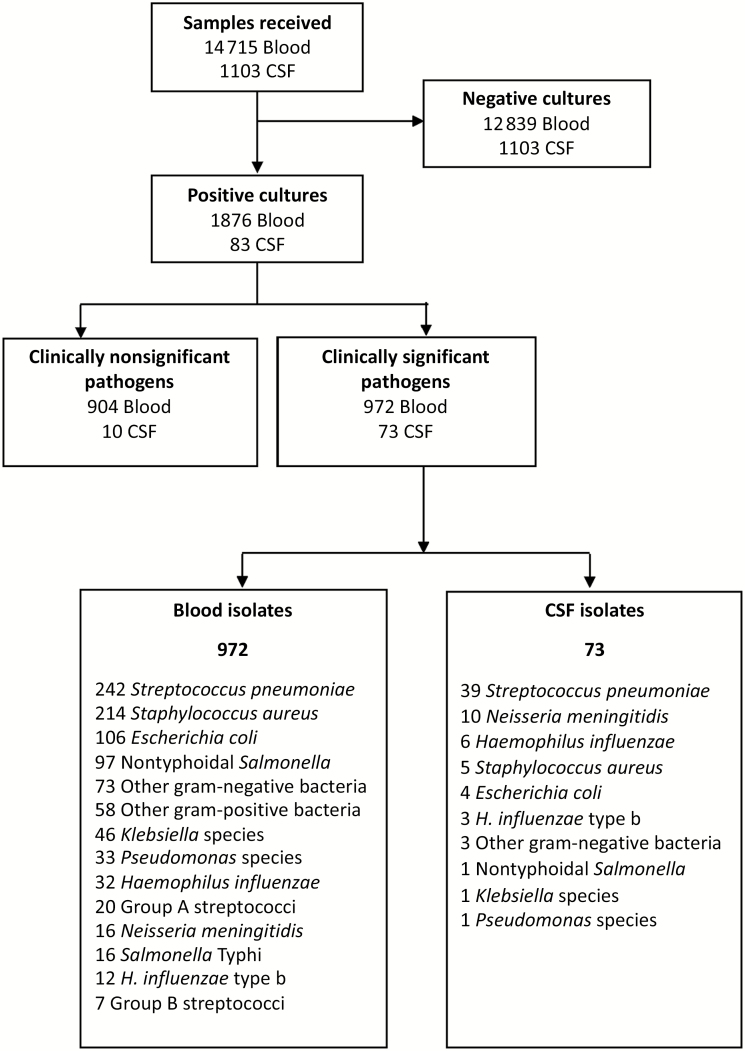
Sampling profile and pathogen outcome from blood and cerebrospinal fluid (CSF).